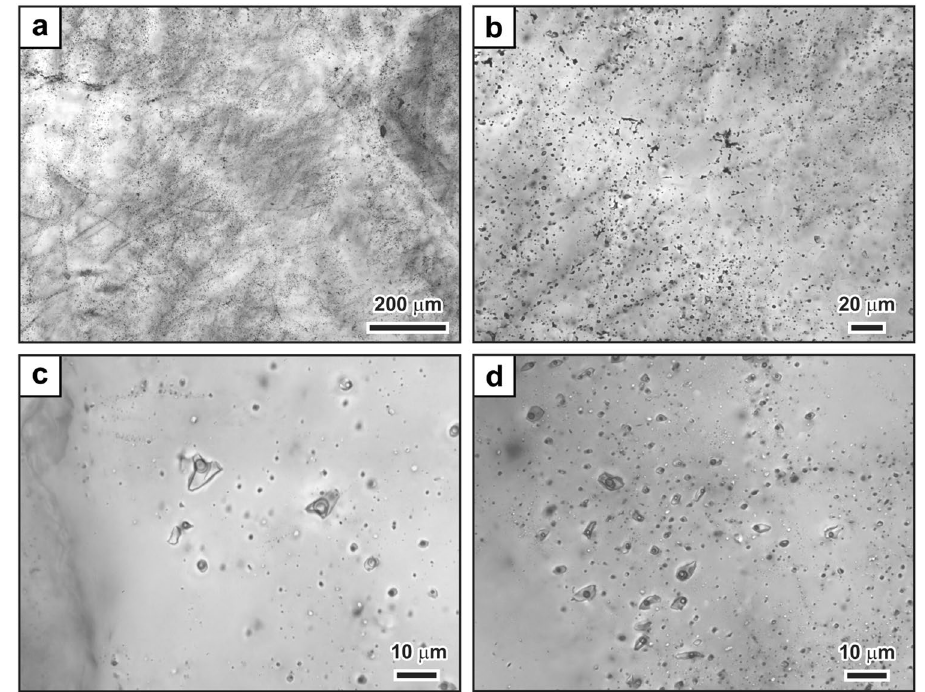
Figure 5. Fluid inclusion characteristics of extensional vein quartz. ( a ) Wispy texture from myriads of healed microfractures defined by inclusions that are typically < 5 μm in size. ( b ) High magnification image showing decrepitation textures and inclusions with variable phase proportions. ( c ) Healed microfracture of equant- shaped H 2 O–CO 2 fluid inclusions. The inclusions contain aqueous liquid and a double bubble composed of a bubble of carbonic liquid that encloses a bubble of carbonic vapor. The inclusions show consistent volumetric proportions within the single inclusion assemblage. ( d ) Quartz crystal containing H 2 O-dominant inclusion assemblages with consistent volumetric proportions of liquid and vapor. Such assemblages of inclusions predominate in the latest, clearest euhedral